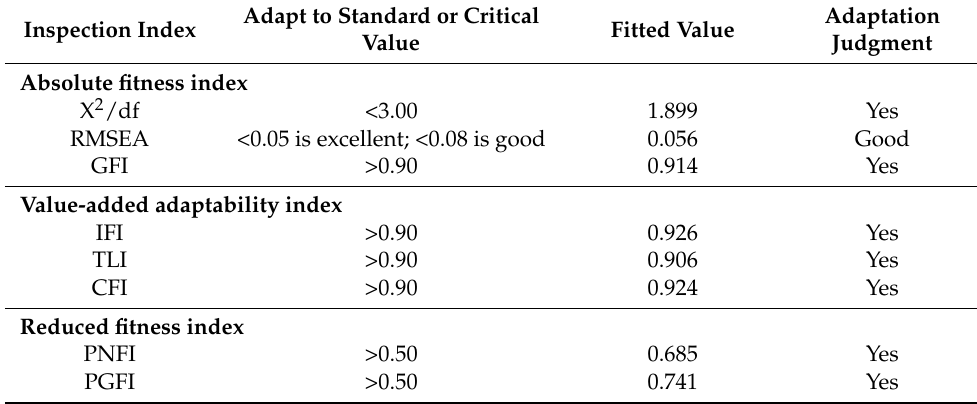
Figure 2. Structural equation model and standardized path coefficient diagram. Table 7. Fitting index results of the structural equation model.